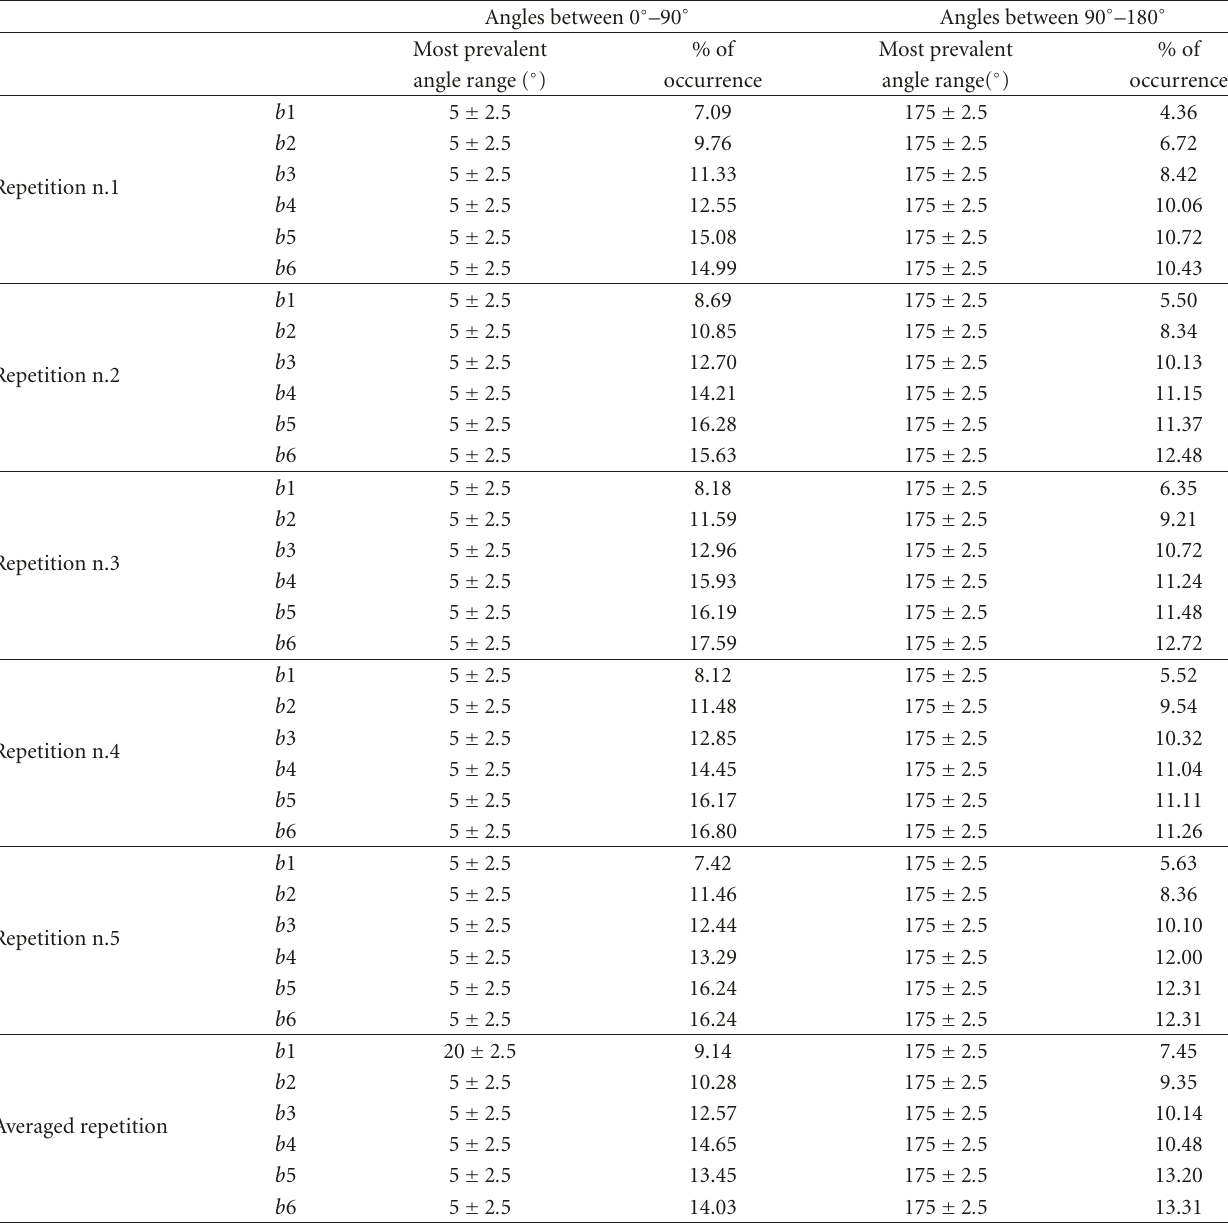
Table 2: Evaluation of the di ff erence in the eigenvector angles between each repetition and the average over all of the repetitions. In this case the measurement is averaged over all of the slices of the volume. Angles between 0 ◦ –90 ◦ Angles between 90 ◦ –180 ◦ Most prevalent % of Most prevalent % of angle range ( ◦ ) occurrence angle range( ◦ )